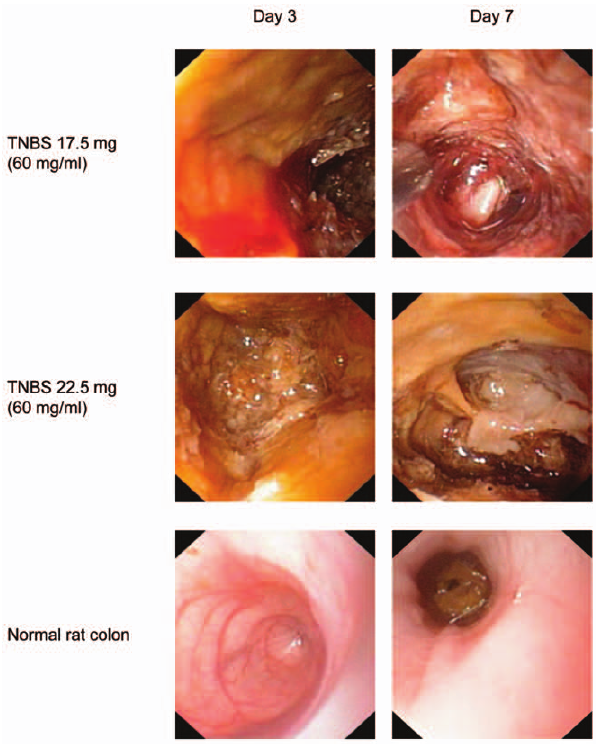
Figure 1. Endoscopic images demonstrating the effect of different doses of TNBS in a fixed concentration of 60 mg/ml. Severe colitis with a yellowish membrane and coprostasis was noted at day 3, and mucosal shedding, stenosis and necrosis was evident at day 7 in rats given TNBS 17.5 mg and 22.5 mg (0.29 ml and 0.38 ml, respectively). The bottom panel depicts examples of normal rat